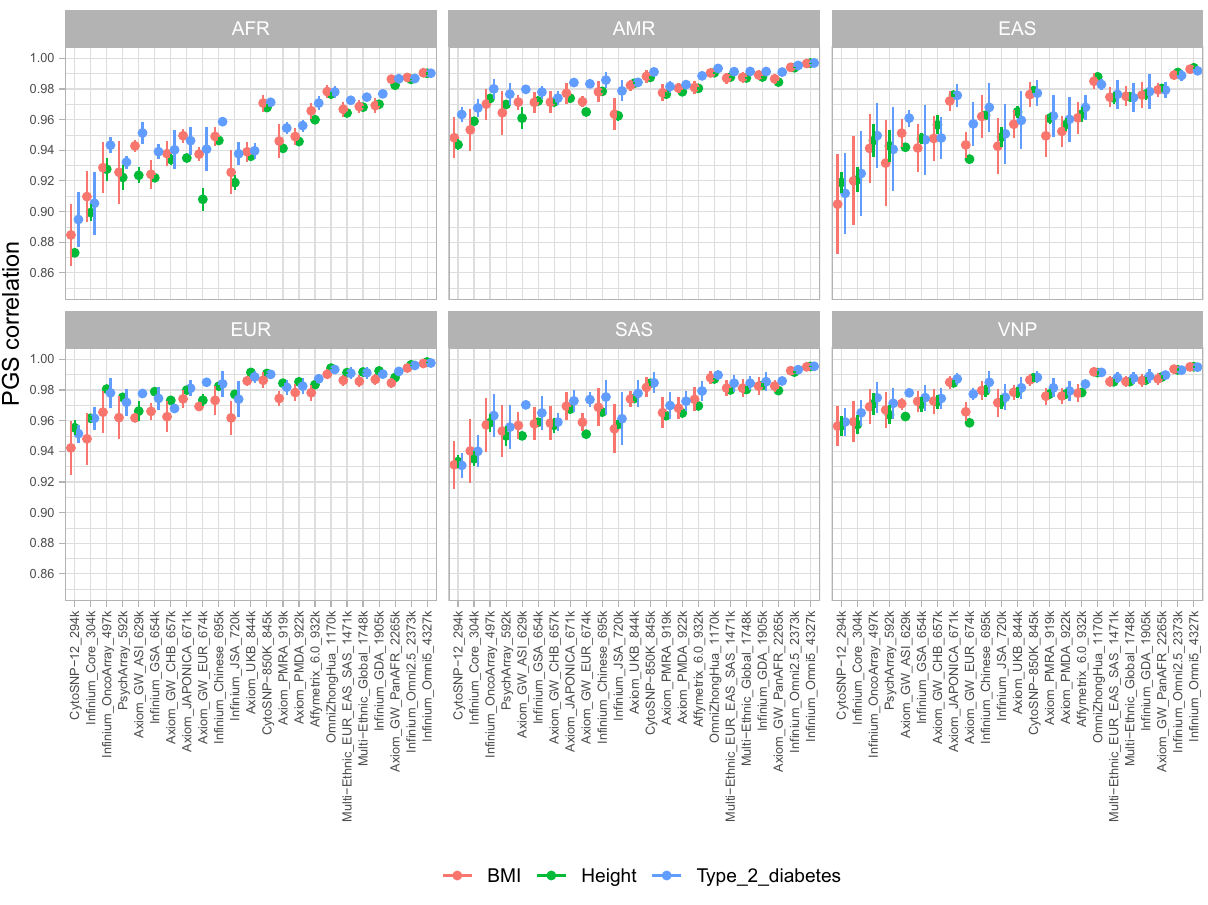
Figure 3. Correlations between PGS estimated from imputed genotyping data of 23 SNP arrays and PGS estimated from WGS in six different populations with three phenotypes including height, BMI, and type 2 diabetes. The dots and the vertical lines present the mean and standard deviation of PGS correlation at various p-value settings including 5e−08, 1e−07, 1e−06, 1e−05, 0.0001, 0.001, 0.01, 0.1, 0.2, 0.3, 0.5, and